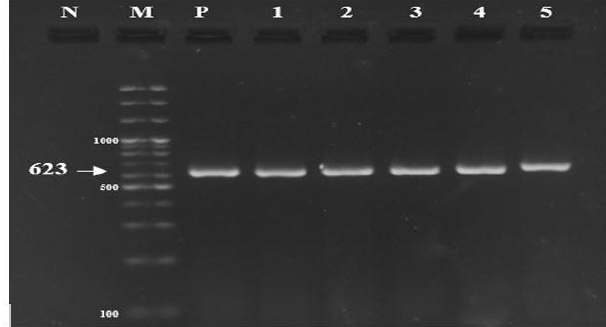
Fig. 1: PCR products of uidA gene. Lane M, DNA molecular standard; lane 1-5 positive tested samples giving 623bp product size; lane N, negative control and lane P control positive.